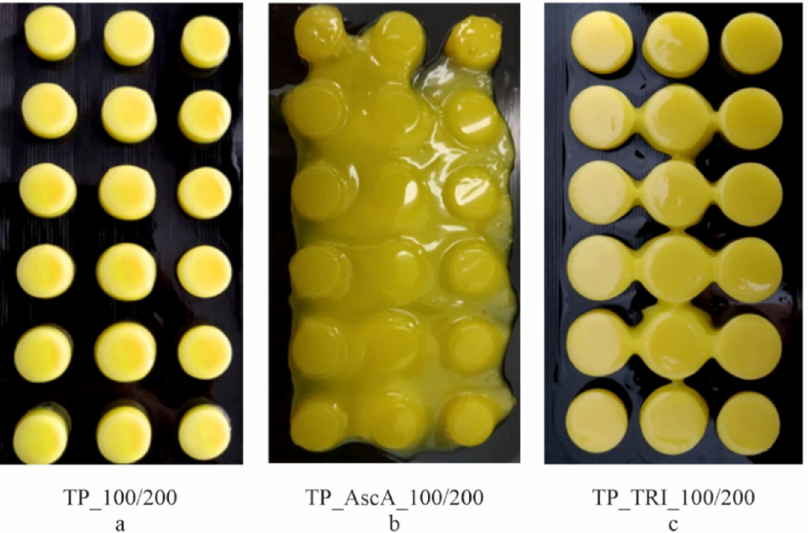
Figure 6. Placebo tablets made of different compositions: without a co-initiator ( a ), with ascorbic acid ( b ), with triethanolamine ( c ), printed with 100/200 printing profile.